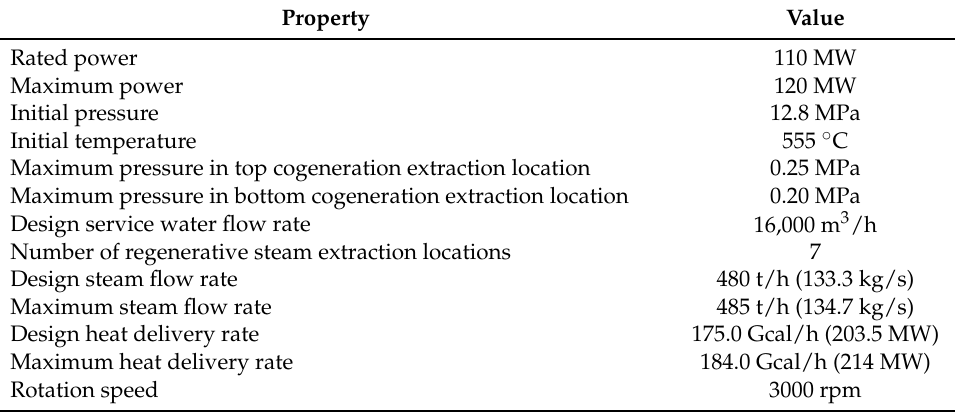
Table 1. Factory specifications of the turbine unit.